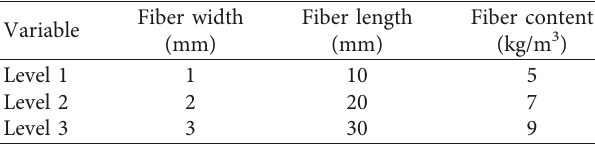
Table 4: Details of mix proportions in the L Experimental no.